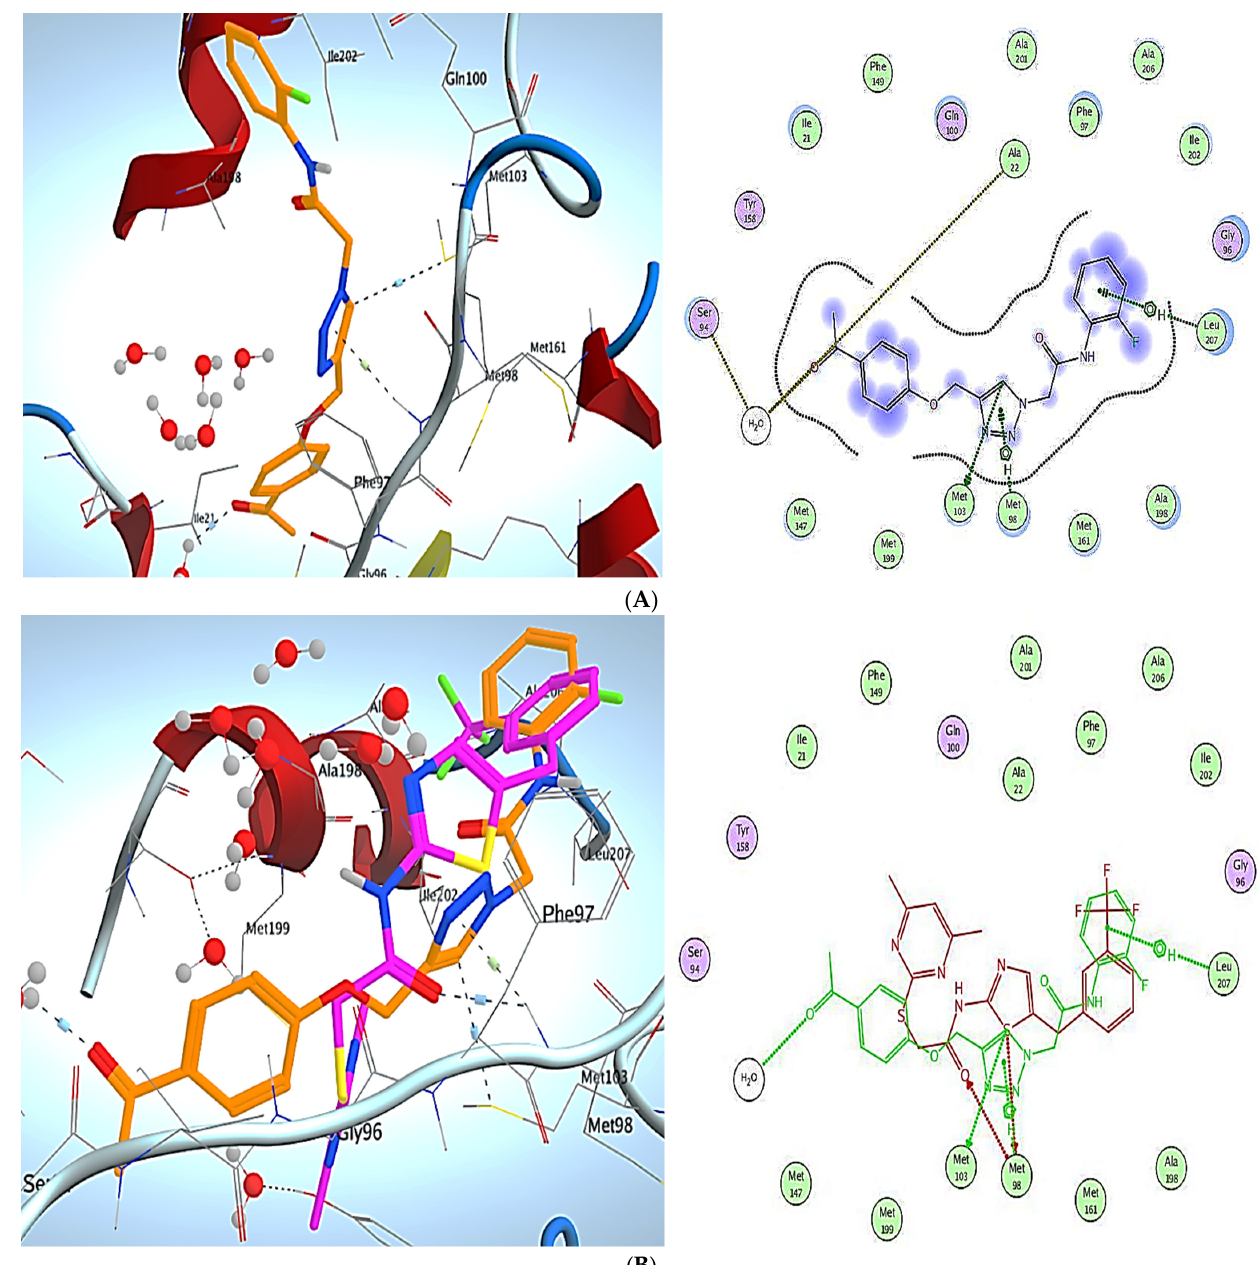
Figure 5. ( A ): Docking and binding pattern of compound 9 into InhA active site (PDB ID: 4UVD) in 2D (right panel) and 3D (left panel). ( B ): An overlay of the docked pose of compound 9 (brown) with the co-crystallized ligand (purple) into inhA active site in 2D (right panel) and 3D (left panel).